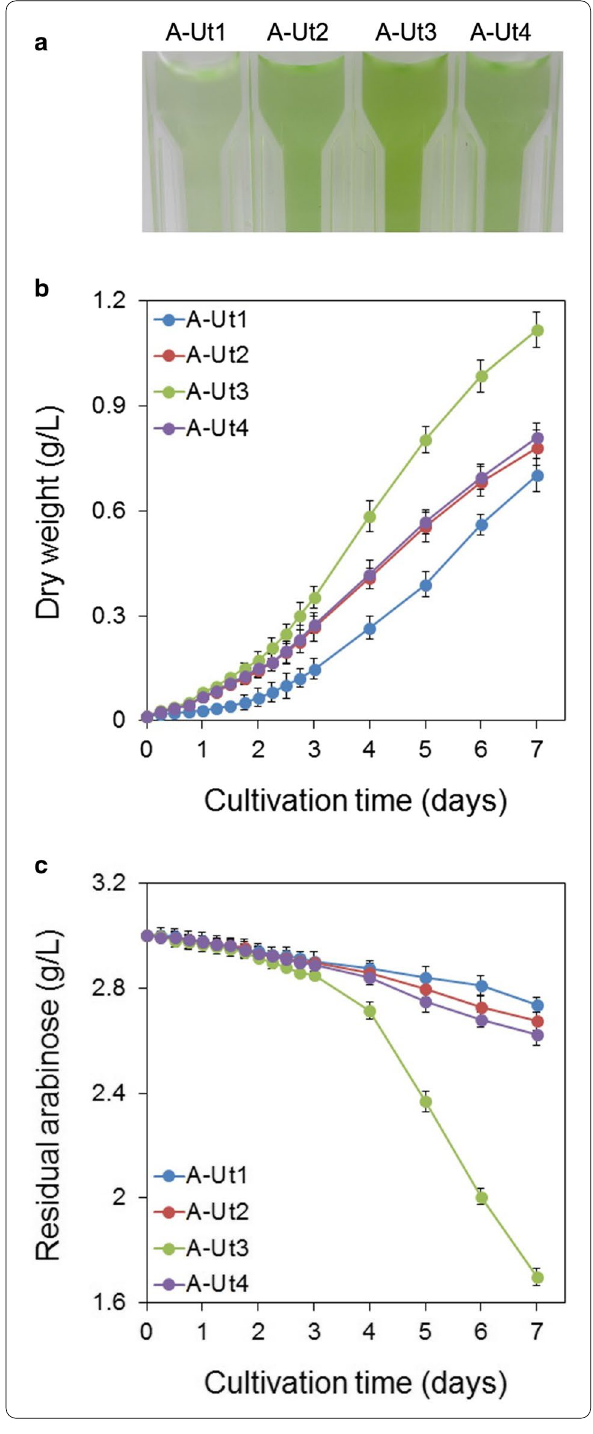
ited by the A-Ut1, A-Ut2 and A-Ut4 strains. At the 7th arabinose uptake than the A-Ut4 strain (Fig. 4c, Addi- tional File 1: S1b, d, f, h).